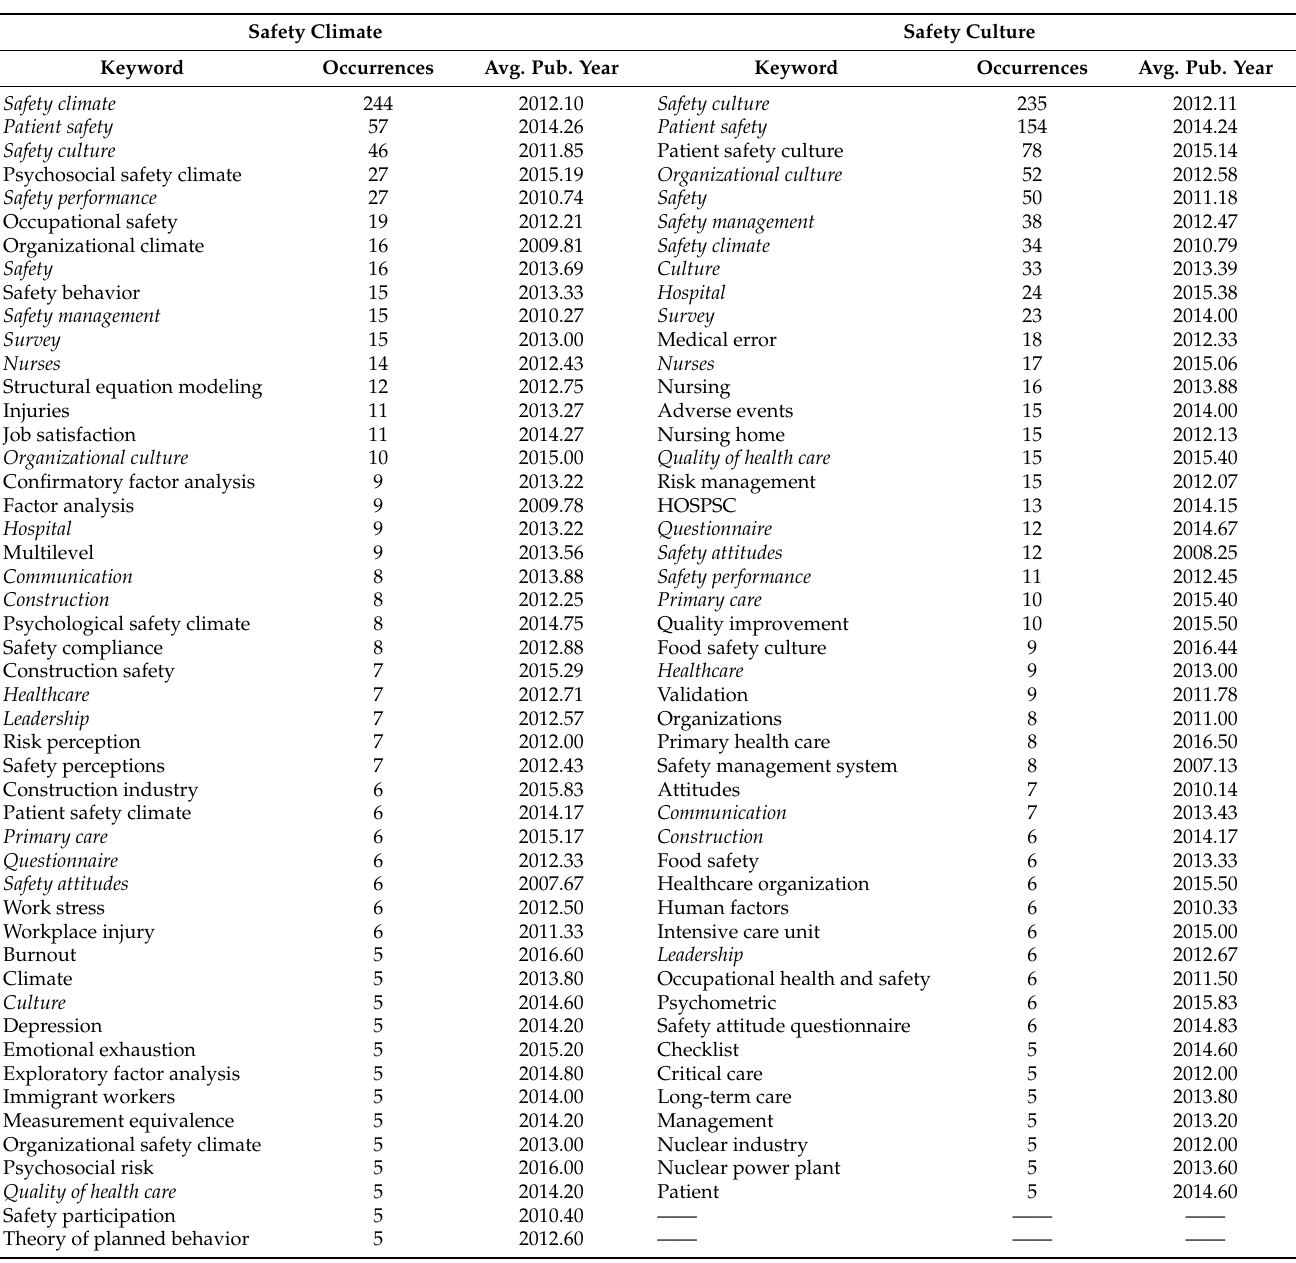
Table 6. Distribution of keywords for safety climate and safety culture research (minimum occurrence ≥